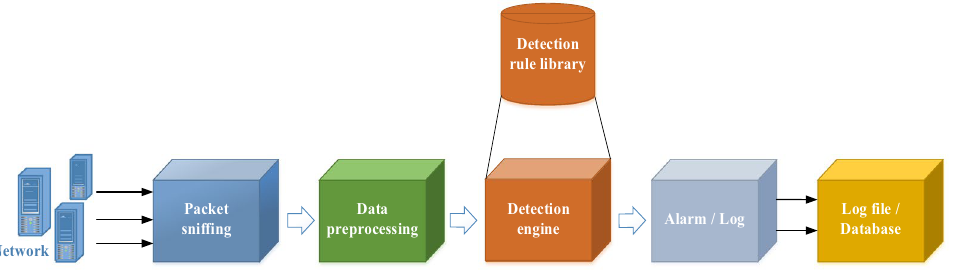
Figure 5. Flow chart of the IDS.